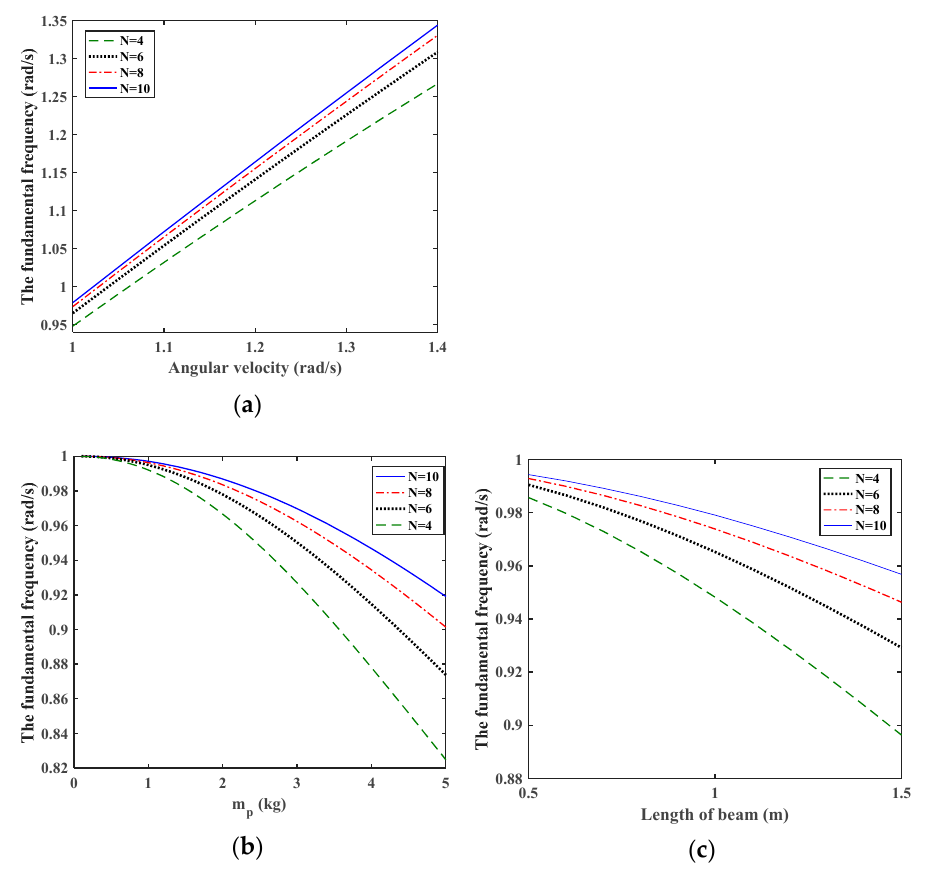
Figure 9. The relationship of the fundamental frequency and three factors with respect to the number of elements: ( a ) effect of rotational velocity, ( b ) effect of payload mass, ( c ) effect of length of flexible beam.